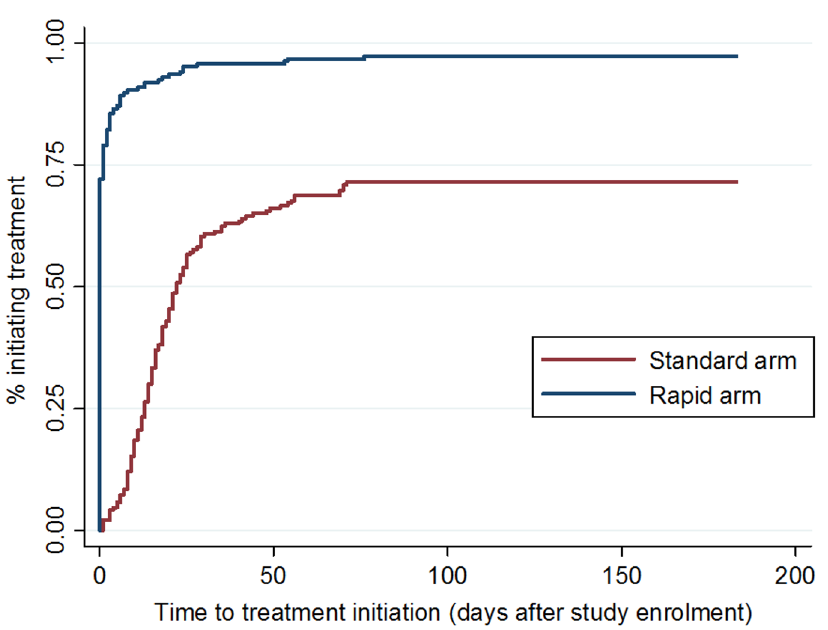
Fig 3. Time to ART initiation, by study arm. Cumulative incidence of ART initiation in each study arm, by number of days since study enrollment.